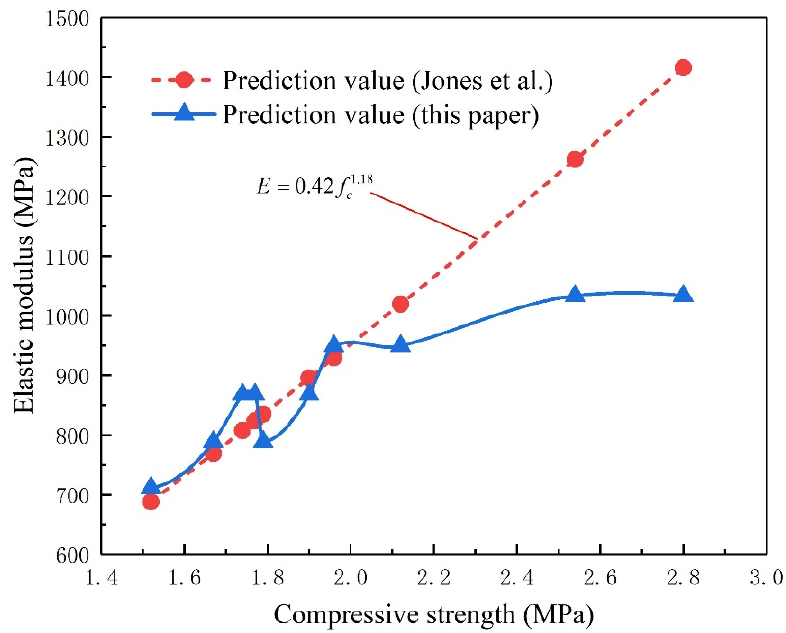
Figure 12. Comparison of elastic modulus theory of foamed concrete with existing research (Jones et al. [22]).